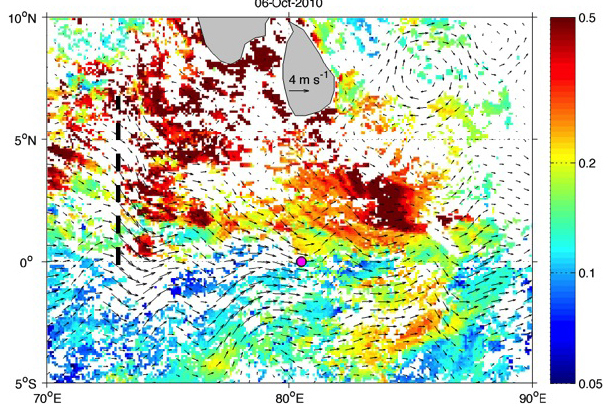
Figure 6. Chlorophyll map created from a 15-day average of MODIS Aqua data centered on 6 October 2010 (peak 1 in Fig. 5). The mooring on the equator at 80.5 ◦ E is marked with a magenta circle. Vectors are OSCAR geostrophic currents calculated from satellite altimetry and scatterometry for a 5-day period centered on 1 October 2010. The figure illustrates the high chlorophyll from the Maldives ( ∼ 73 ◦ E) being advected eastwards by the large-scale flow and southwards towards the mooring by wave processes. At the resolution of this coastline, it is not possible to see the Maldives, so we have indicated their location with a thick dashed line.